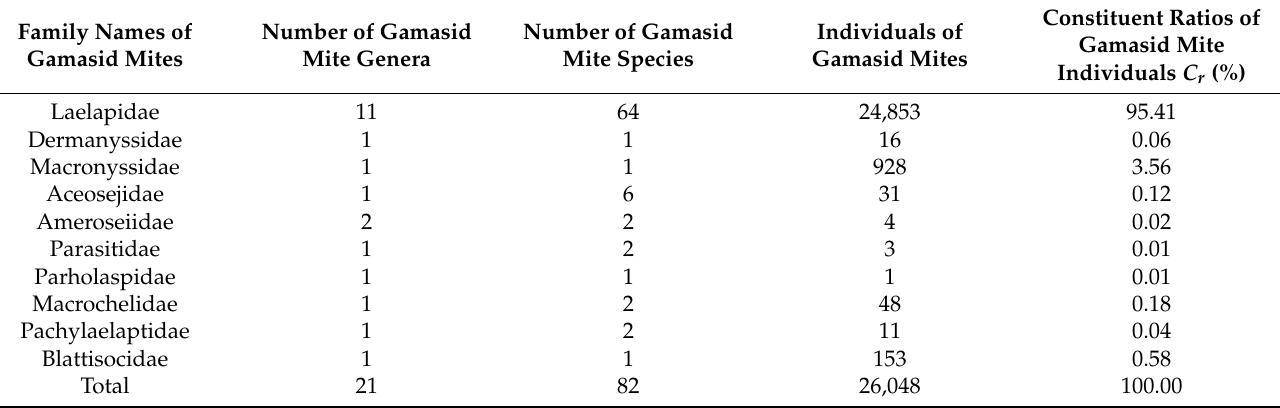
Table 2. Identified gamasid mites from nine survey sites in Three Parallel Rivers Area in northwest Yunnan of China